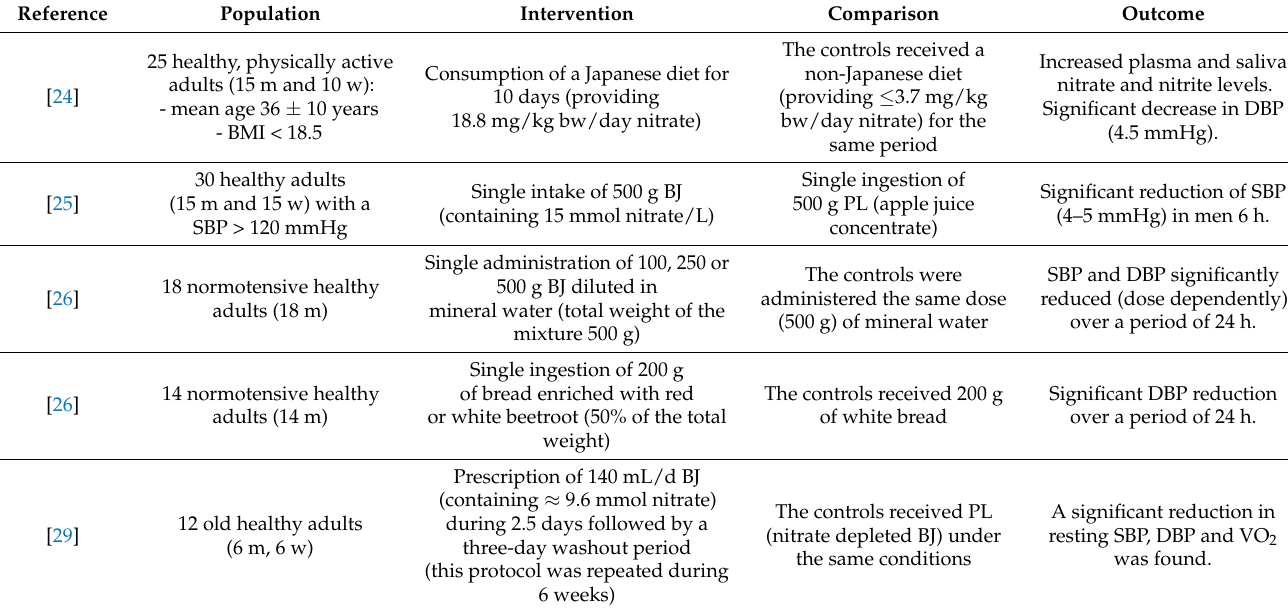
Table 2. Selected studies addressing the antihypertensive effects of nitrate that have been included in this article (PICO format). Reference Population